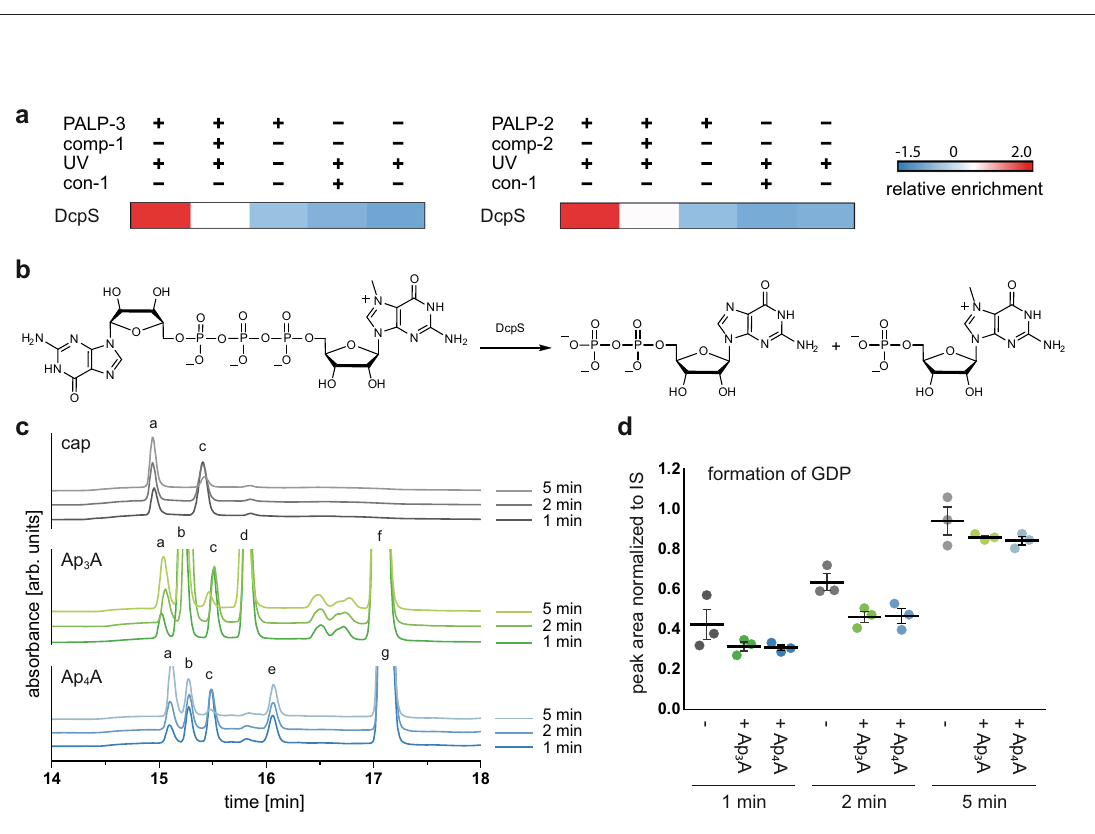
Fig. 3 Overview of the proteomic analysis of the PAL experiments using HEK293T cell lysates. a Western blot analysis with ExtrAvidin ® -Peroxidase showing the enrichment of labeled proteins under optimized conditions using PALP-1 (left) and PALP-2 (right) as indicated after irradiation with UV light (365 nm) for 5 min. b As for a but usage of PALP-3. Structure of PALP-3 is shown. c Heat map representation ( Z -scores) of proteins that were quanti fi ed in the respective experiments in at least four out of six measurements and that passed a one-way ANOVA-based multiple-sample test for statistically signi fi cant enrichment, with a permutation-based false discovery rate (FDR) below or equal to 0.01 and S 0 value set to 0.2, followed up by two-sided post hoc Tukey ’ s HSD test (FDR ≤ 0.05) to fi lter for signi fi cant enrichment against all performed control experiments. d Venn diagram showing the distribution of identi fi ed proteins for Ap 3 A probes (data obtained with PALP-1 and PALP-3, green) and the Ap 4 A probe (data obtained with PALP-2, blue). e Extract of biological processes that are signi fi cantly overrepresented in proteins found with Ap 3 A-based probes (PALP-1 and PALP-3, green) and the Ap 4 A-based probe (PALP-2, blue) compared to the global human proteome (gray) according to GO analysis using a one-sided hypergeometric test performed with the Cytoscape BiNGO app (Supplementary Data 2). Global frequency represents the number of genes annotated to a GO term in the entire human proteome, while sample frequency represents the number of genes annotated to that GO term in the protein list obtained by the presented PAL approaches. Source data are provided as a Source Data fi le.